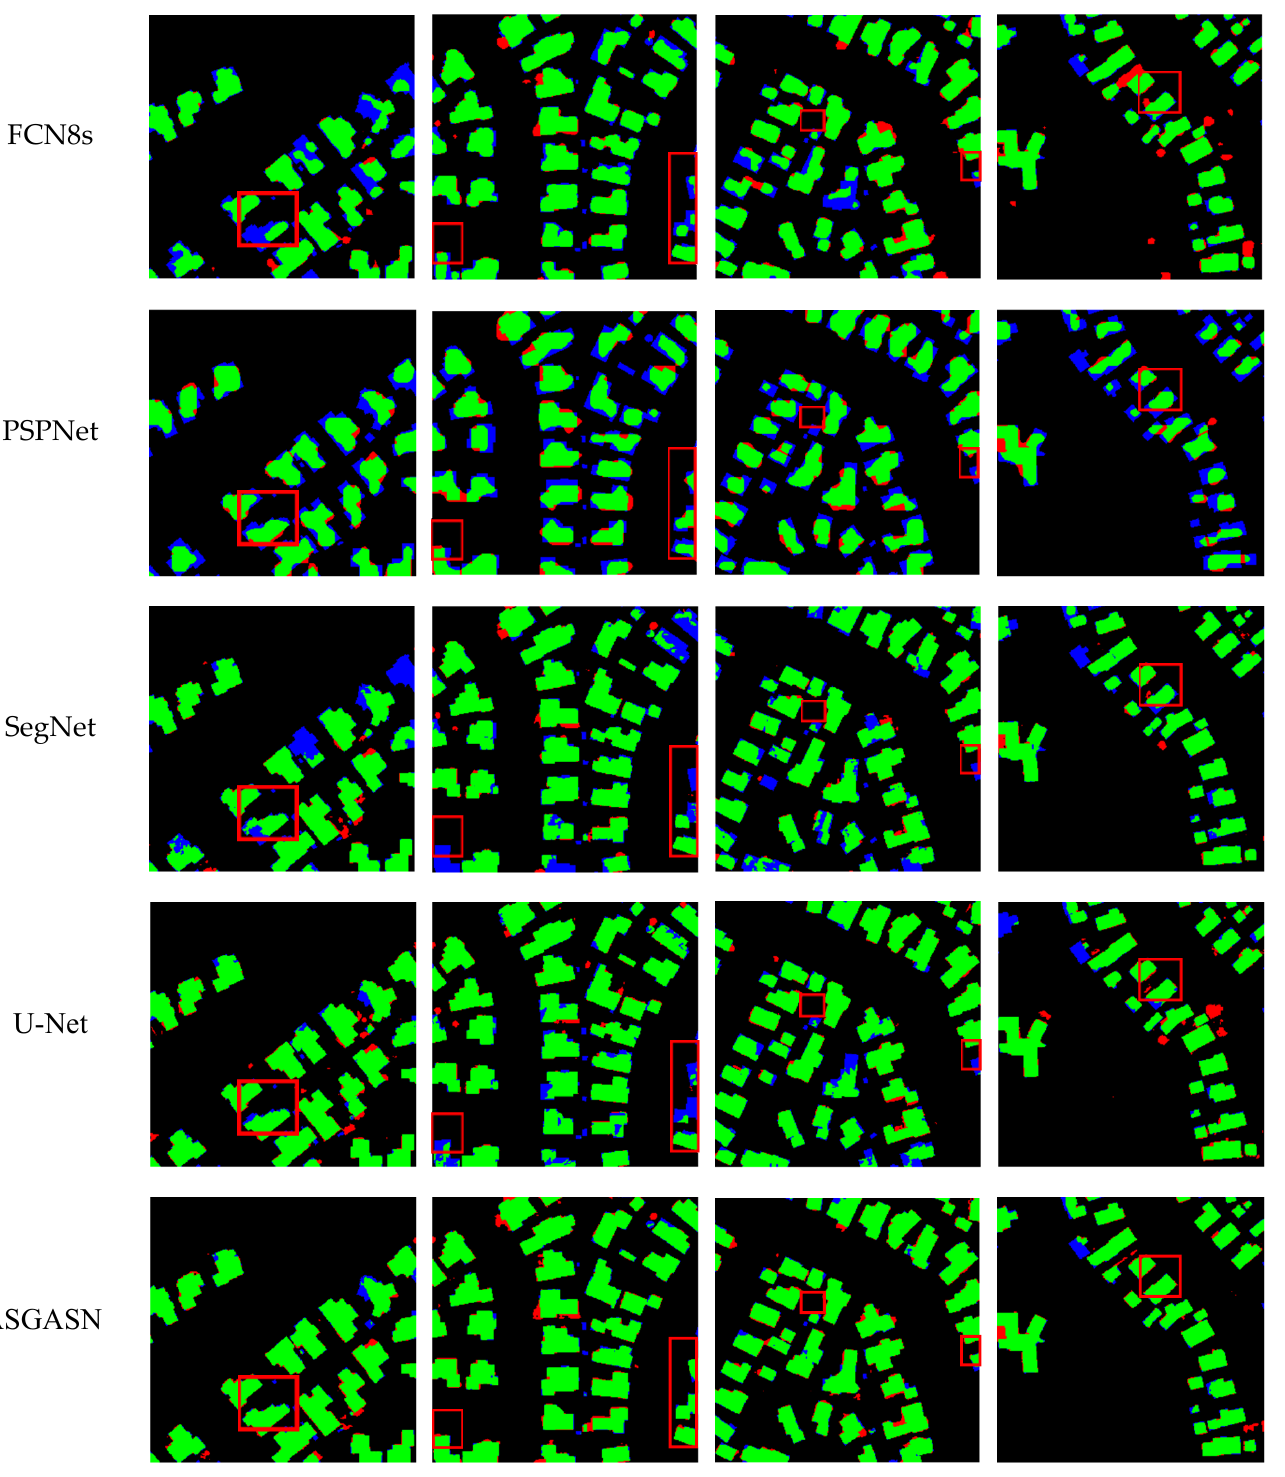
Figure 11. Examples of segmentation results by different models on the WHU dataset. The green, red, blue, and black pixels of the maps represent the true positive, false positive, false negative, and true negative predictions, respectively.